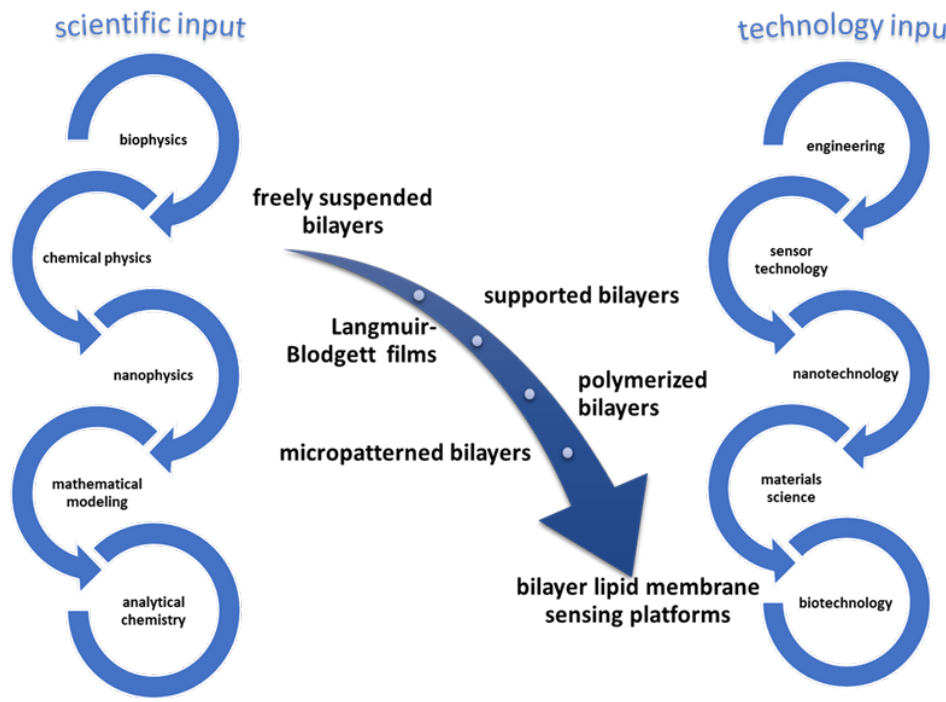
Figure 2. The science and technology input that enabled lipid membrane technology to progress from freely suspended fragile bilayers (black lipid membranes) to rugged nanopatterned sensing